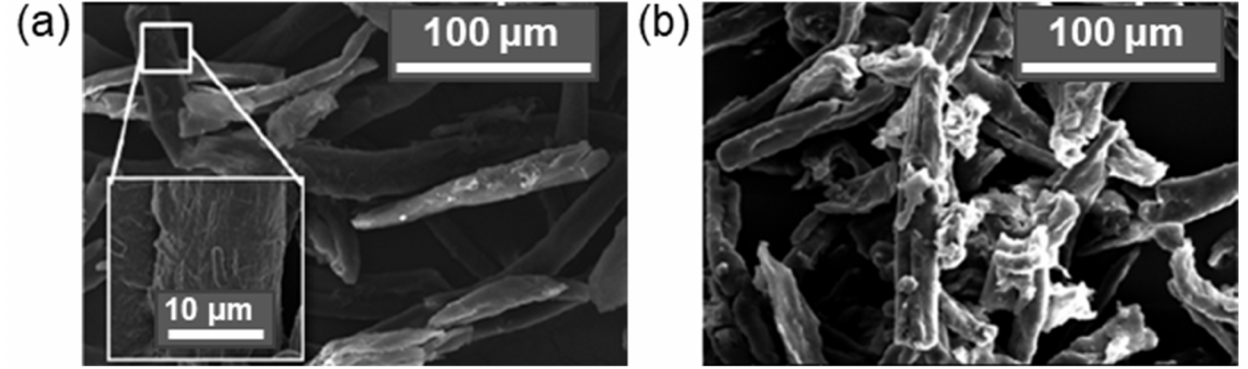
Figure 12. SEM images of CMC before ( a ) and after grafting of oligo(L-lactic acid) ( b ). Reproduced from [82] with permission of Royal Society of